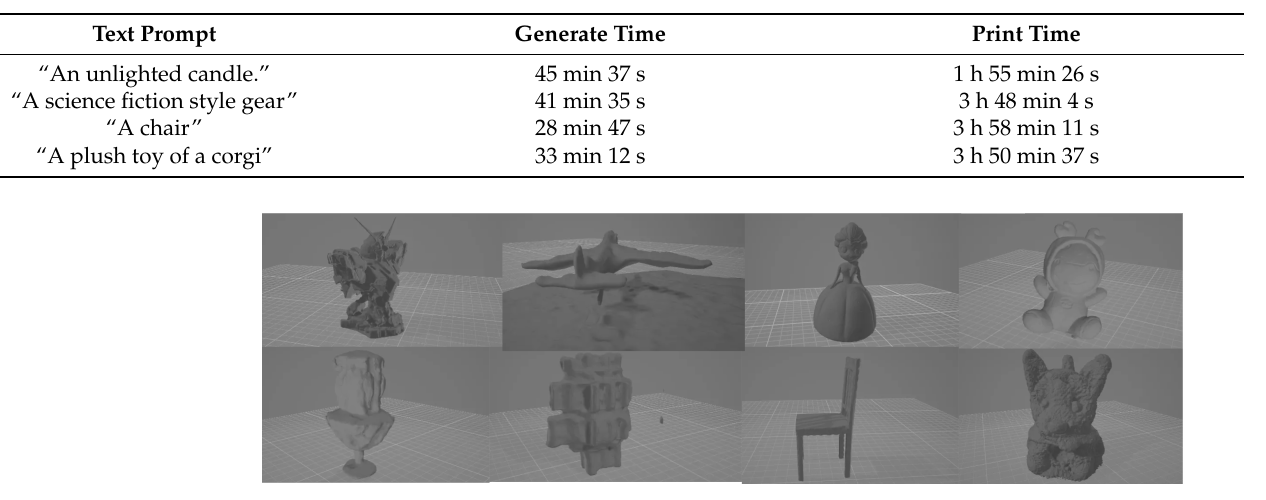
Figure 6. 3D content generation